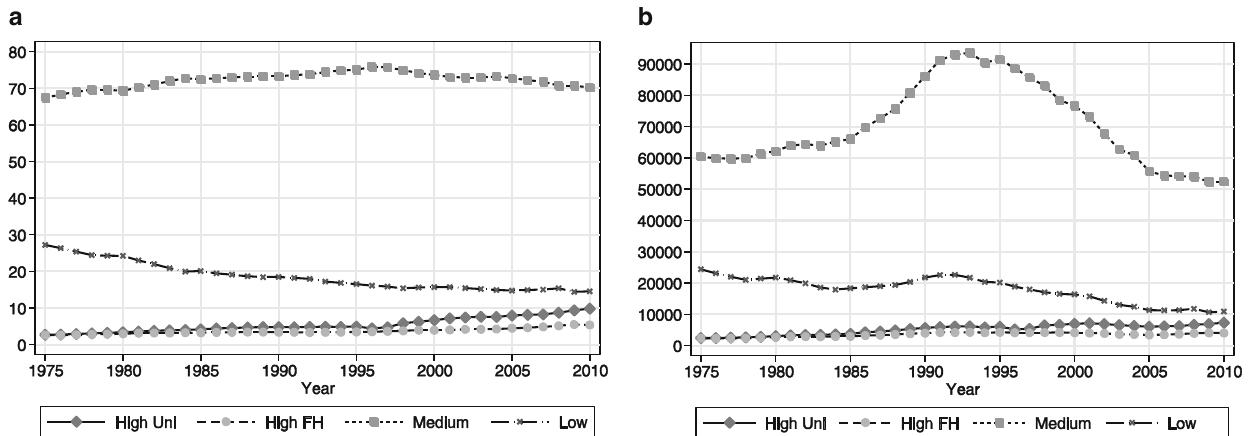
Fig. 1 Education Distribution (Shares and Absolute Numbers, 25–35 Years, 1975–2010) (Source: 2% IABS Sample for full-time workers between 25 and 35 years of age. N =